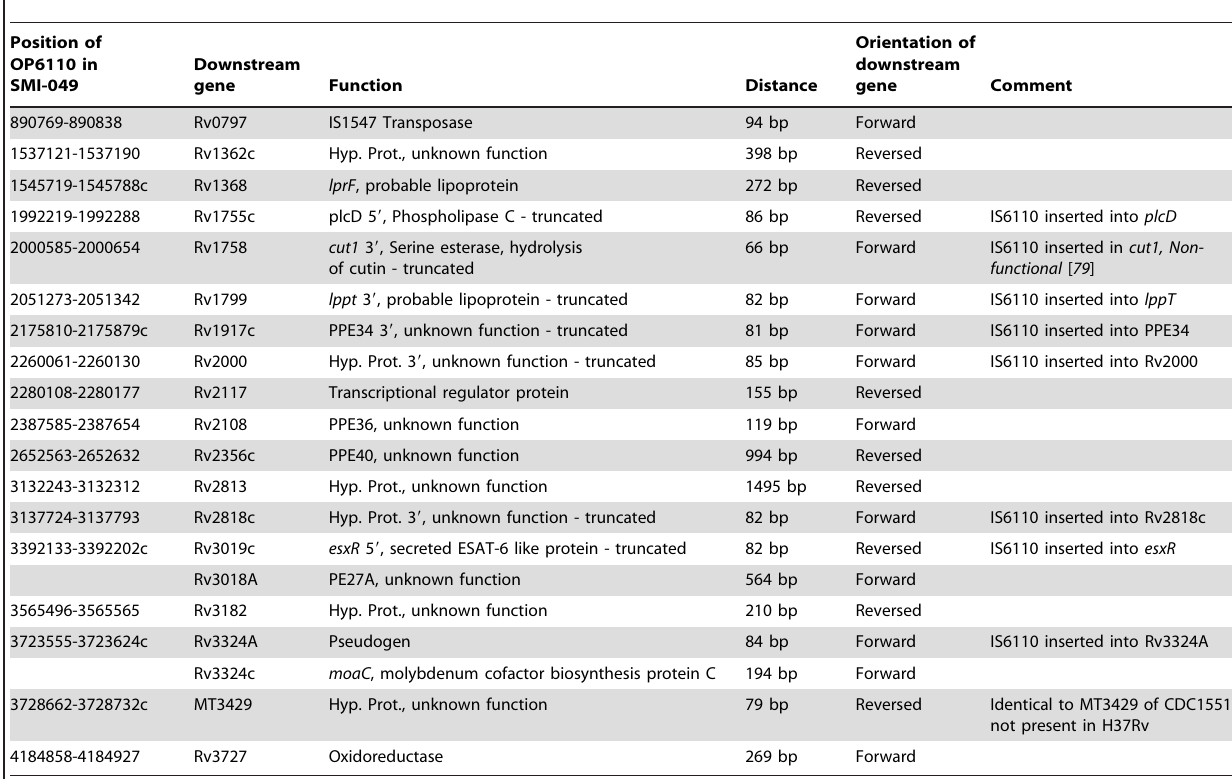
Table 4. Putative genes where IS 6110 insertions may alter promoter activity.